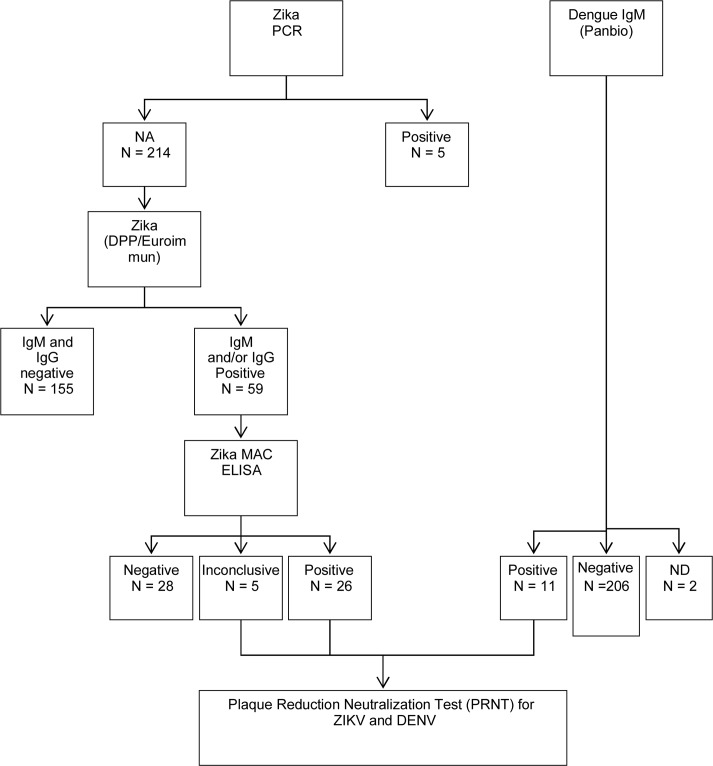
Algorithm for diagnostic tests in symptomatic and asymptomatic pregnant women.